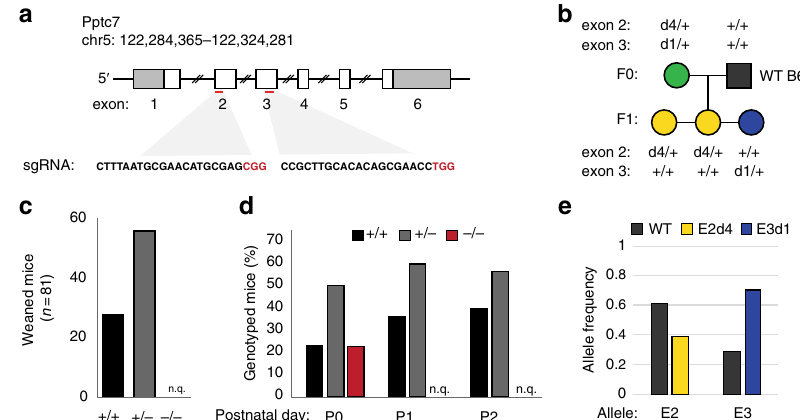
Fig. 1 Global, CRISPR-mediated knockout of Pptc7 causes perinatal lethality. a Targeting strategy for the Pptc7 locus in Mus musculus is shown; two sgRNAs were designed to exons 2 and 3 and injected simultaneously into a one cell zygote. b The founder mouse (green circle) was bred to a wild type C57B6/J mouse (gray square), generating F1 pups possessing deletions (labeled dX where X is number of base pairs deleted) in exon 2 (yellow circles) or exon 3 (blue circles). This segregation pattern indicates the founder mouse is compound heterozygous (null) for Pptc7 . c No Pptc7 knockout pups were found at weaning ( n = 81; n.q. — not quanti fi ed). d Pptc7 knockout pups are born at Mendelian frequencies, but no live pups were found at postnatal day 1 (P1) ( n = 14) or day 2 (P2) ( n = 17) (reported as n.q. — not quanti fi ed). e Frequency of WT (gray) or mutant (yellow, E2; blue, E3) alleles at exon 2 (E2) and exon 3 (E3) in skeletal muscle of the F0 founder mouse, demonstrating